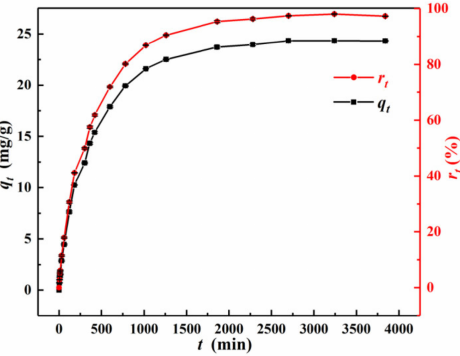
Figure 8. Cr(VI) adsorption amount ( q t ) and removal rate ( r t ) changes with the increasing contact time at 298.15 K,